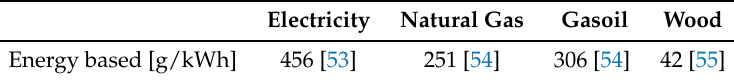
Table 1. CO 2 emissions energy